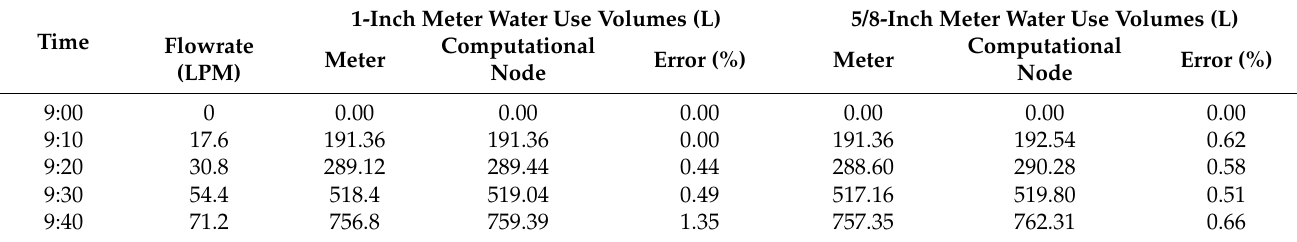
Table 7. Results from laboratory experiment 1 for the 1-inch and 5/8-inch Master Meters.